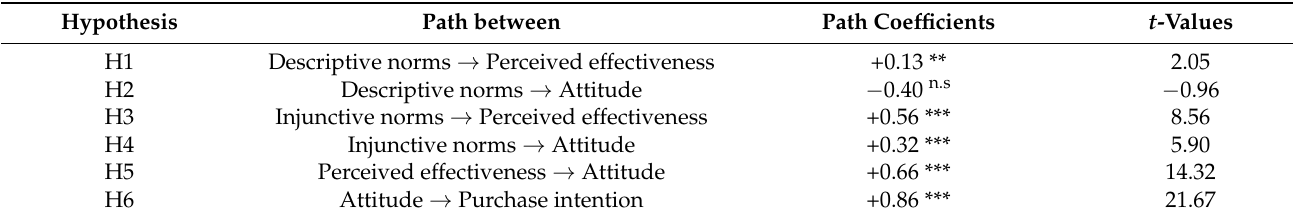
Table 3. Hypothesis test